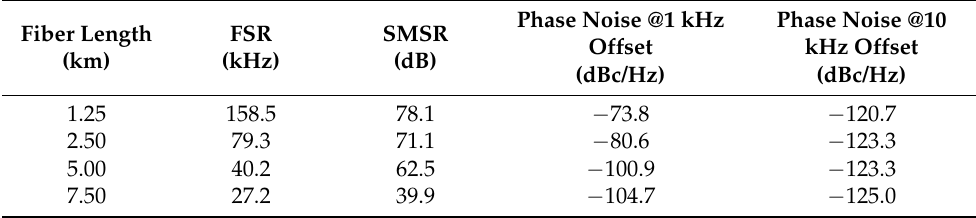
Figure 14. Photograph of the proposed application of the OEO combined with the optical fiber path selector. Table 3. FSR, SMSR and phase noise measurements of the single-loop OEO for different optical lengths [100].